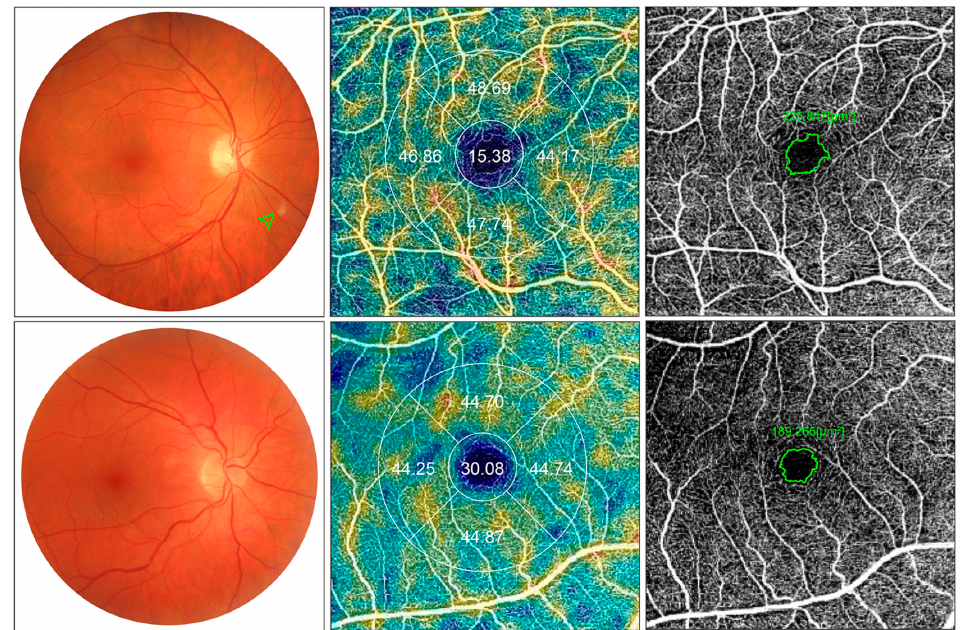
Figure 6. Composite images of case-control comparison. Top row: COVID-19 patient with bilateral pneumonia due to SARS-COV-2 case. Bottom row: Age-, sex- and laterality-matched control. Fundus retinography (left column), optical coherence tomography angiography (OCTA) vessel density maps (middle column), and OCTA image of the superficial capillary plexus (SCP) are depicted. In this case, a cotton wool spot is presented in the fundus retinography (green arrowhead). Reduced vessel density (15.38 vs. 30.08) and enlarged foveal avascular zone (FAZ) (225.8 vs. 189.2 µ m 2 ) are observed in the case compared to the matched control. 4.5 × 4.5 mm en face angiogram of the SCP are shown. Manually delineated FAZ are shown in